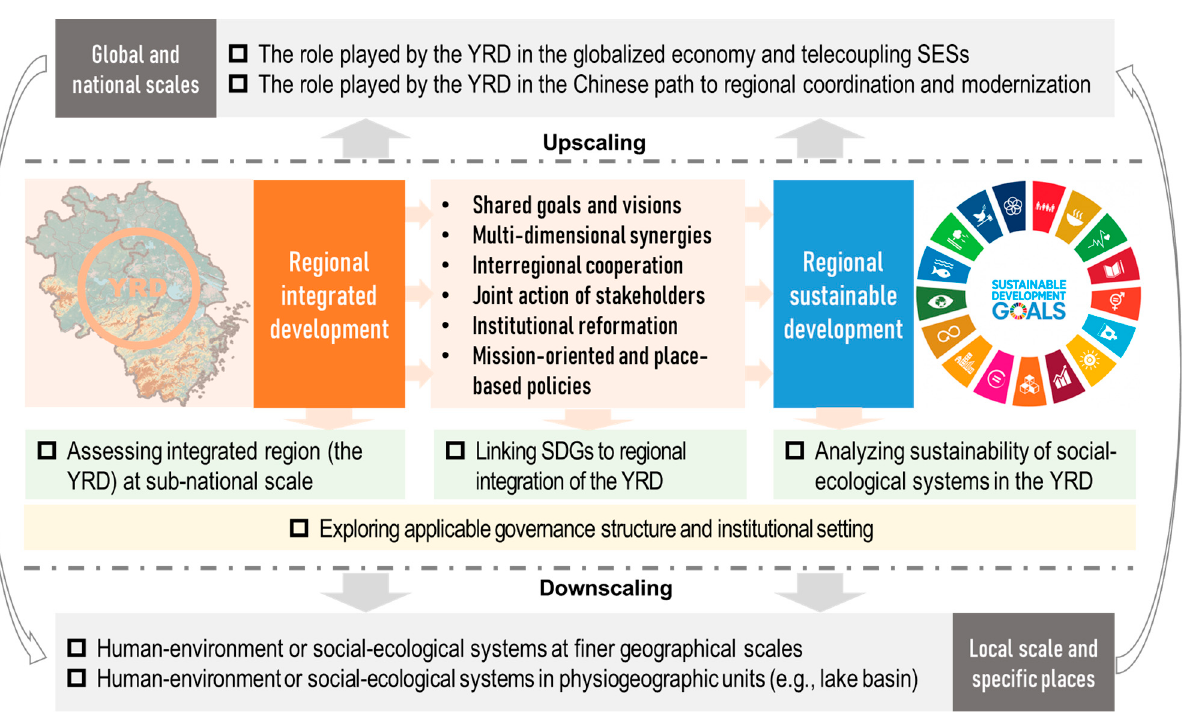
Figure 2. Conceptual framework and research agendas of regional integrated and sustainable development in the YRD. Table 1. The association between 17 SDGs and major tasks of regional integrative development in the YRD.